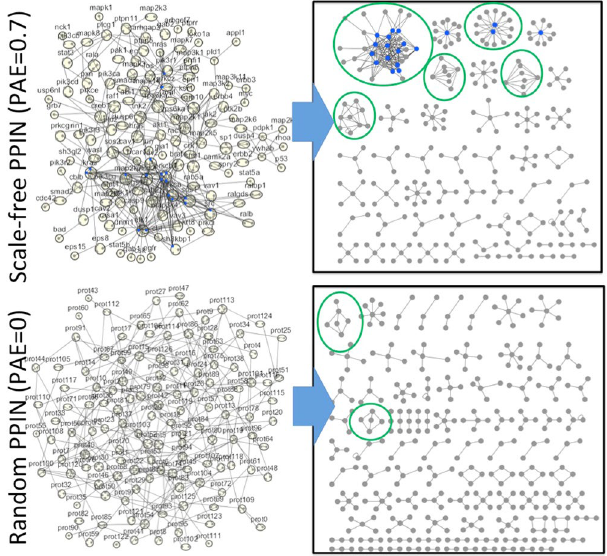
Figure 5. Scale-free PPINs produce fitter IINs than random PPINs. We performed fitness sampling for selective IINs on the ErbB scale-free like PPIN (top) and a random network with the same number of proteins and PPIs (bottom). For the scale-free like PPIN (top) fewer interfaces (n = 290) were needed to produce selective motifs, including 2000 squares (in green circled modules). Without hub proteins, the random PPIN (bottom) produced only 12 squares, and introduced many additional interfaces (n = 356) in order to maintain selective motifs. The same trends held with the CME PPIN (Fig. S1). IINs discovered with random PPINs were also less fit than those found with scale-free PPINs (see Table S7). Nodes with > 9 partners are shown in